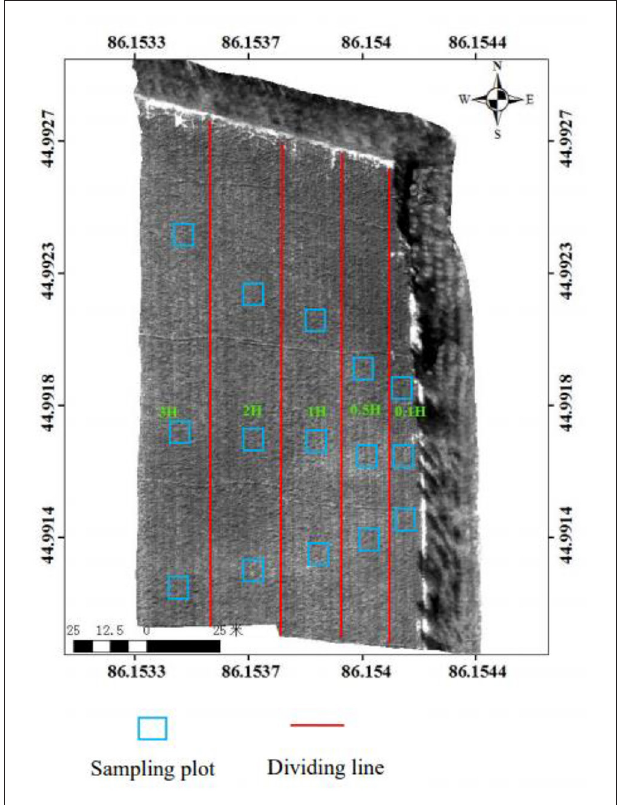
FIGURE 2 | Experimental